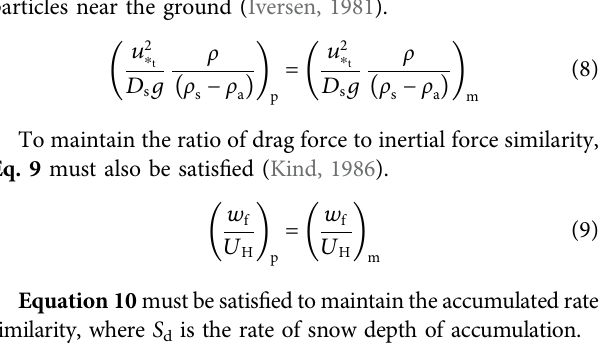
Frontiers in Earth Science |